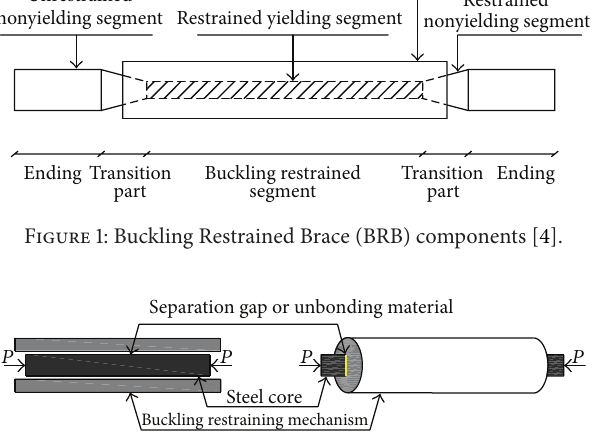
Figure 2: Buckling Restrained Brace system (BRBs)